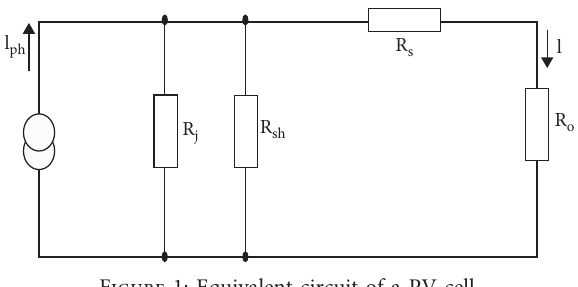
Figure 1: Equivalent circuit of a PV